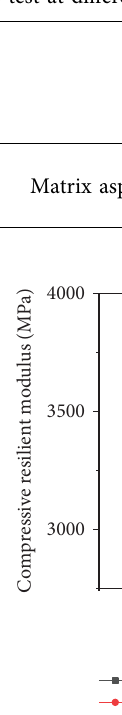
Figure 14: Variation curve of the compressive strength of the cylinder with the strength of the cement slurry.